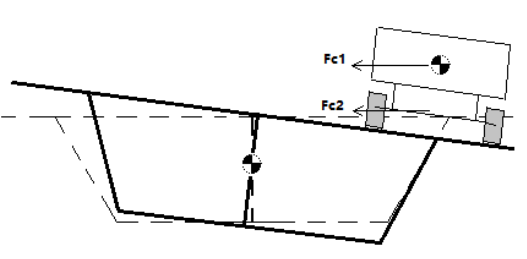
Fig. 2. Centrifugal forces on the moving